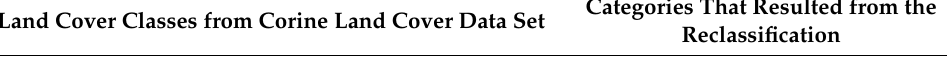
Table A1. Reclassification of Corine Land Cover data. Land Cover Classes from Corine Land Cover Data Set